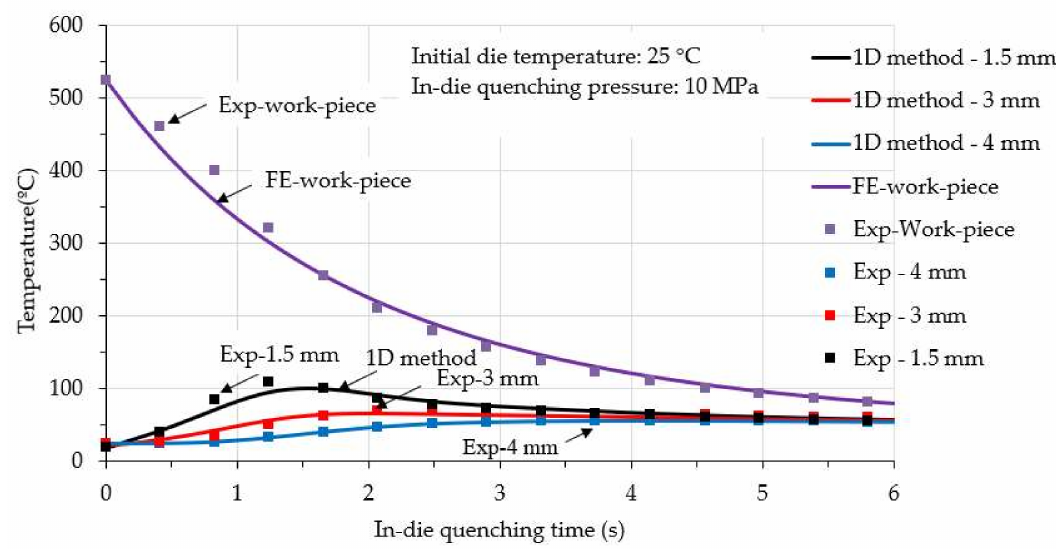
Figure 5. Validation of 1D closed-form method and FE simulation, where solid symbols represent experimentations, and solid lines represent calculation and computational results. The blank thickness was 3